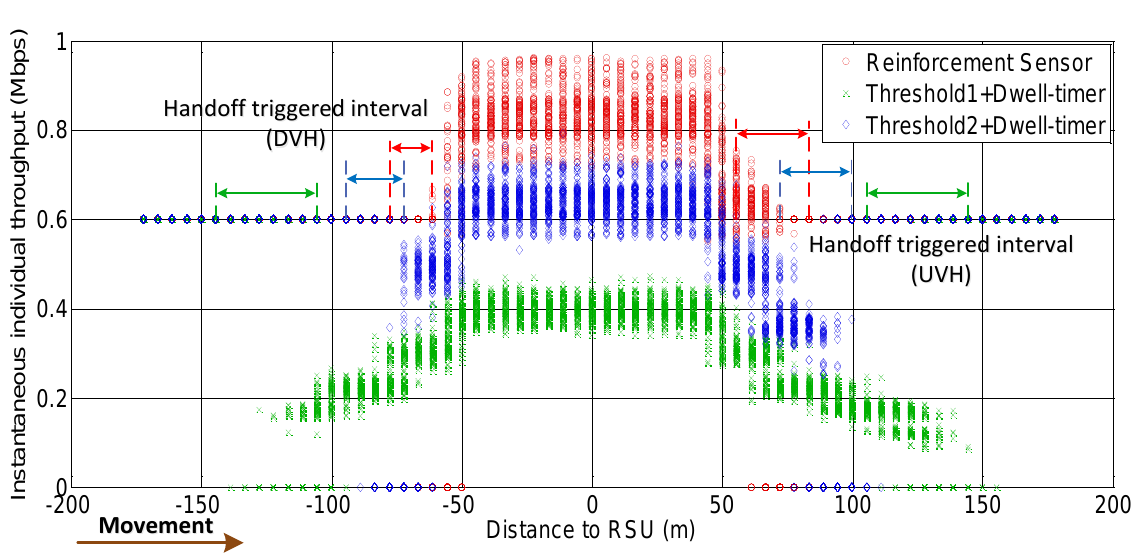
Figure 7. Distribution of individual throughput vs. distance to RSU (arrival rate = 0.5